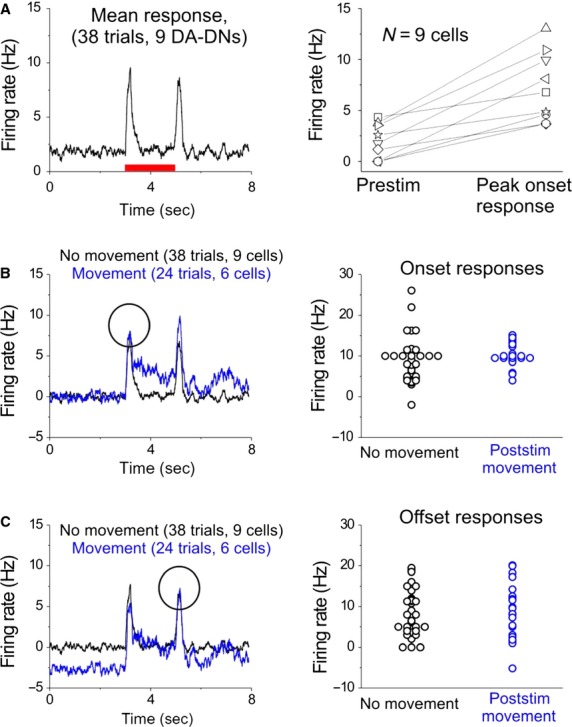
DA-DN mechanosensory responses do not predict subsequent movement. (A) Left: PSTH shows mean response to mechanosensory stimulus in trials without leg movement. Right: Mean change in firing rate shown for each cell after stimulus onset. (B–C) Mean DA-DN firing rates are compared during mechanosensory trials with (blue) and without (black) leg movement after stimulus presentation. (B) Prestimulus firing rate is subtracted from each trace to examine onset responses to stimulus. Left: mean PSTHs; Right: Onset responses for all cells. (C) Poststimulus firing rate is subtracted from each trace to examine offset responses. All panels as in (B).